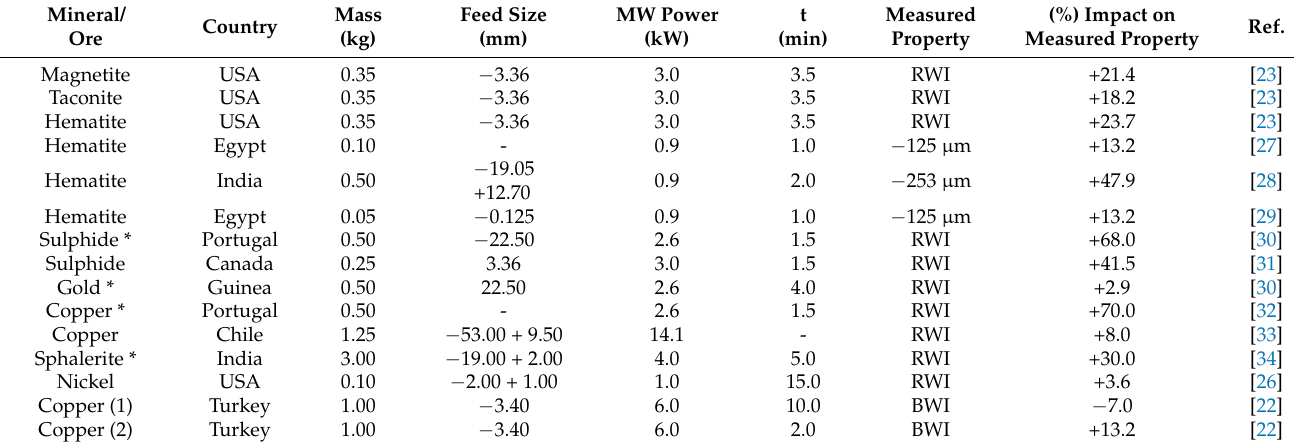
Table 1. Mineral/ore studies for microwave-assisted grinding (2.45